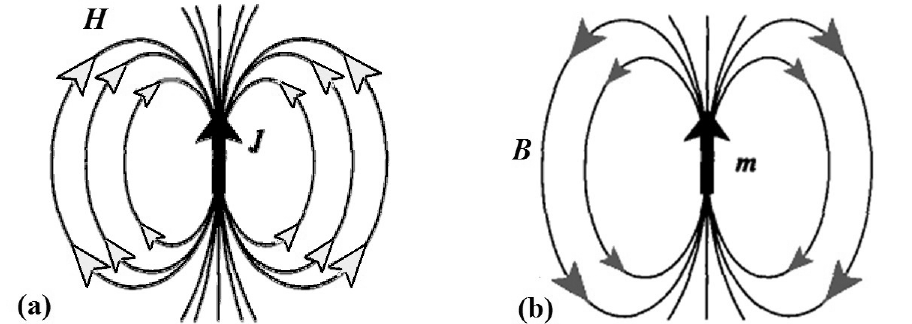
Figure 1. The directionalities of gravitomagnetism and magnetism compared and contrasted [70]: ( a ) the gravitomagnetic field (cid:126) H in the weak field approximation, (cid:126) J is the angular momentum of the central body; ( b ) the magnetic induction (cid:126) B in the neighborhood of a magnetic dipole moment (cid:126) m